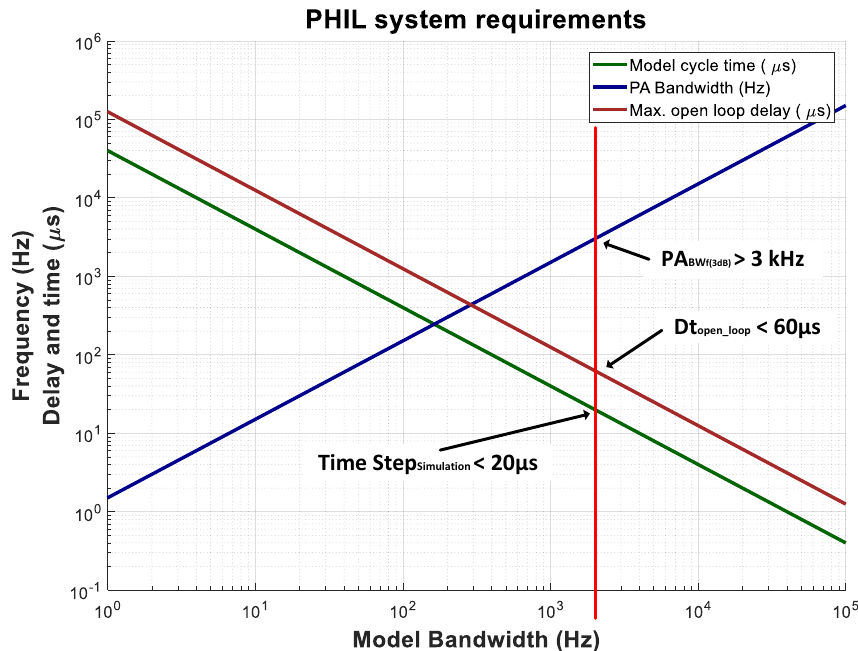
Figure 5. PHIL system requirements depending the bandwidth of the model to test [16]. In this case, an example of an electric grid transient test is given, for which the maximum frequency of interest is 2